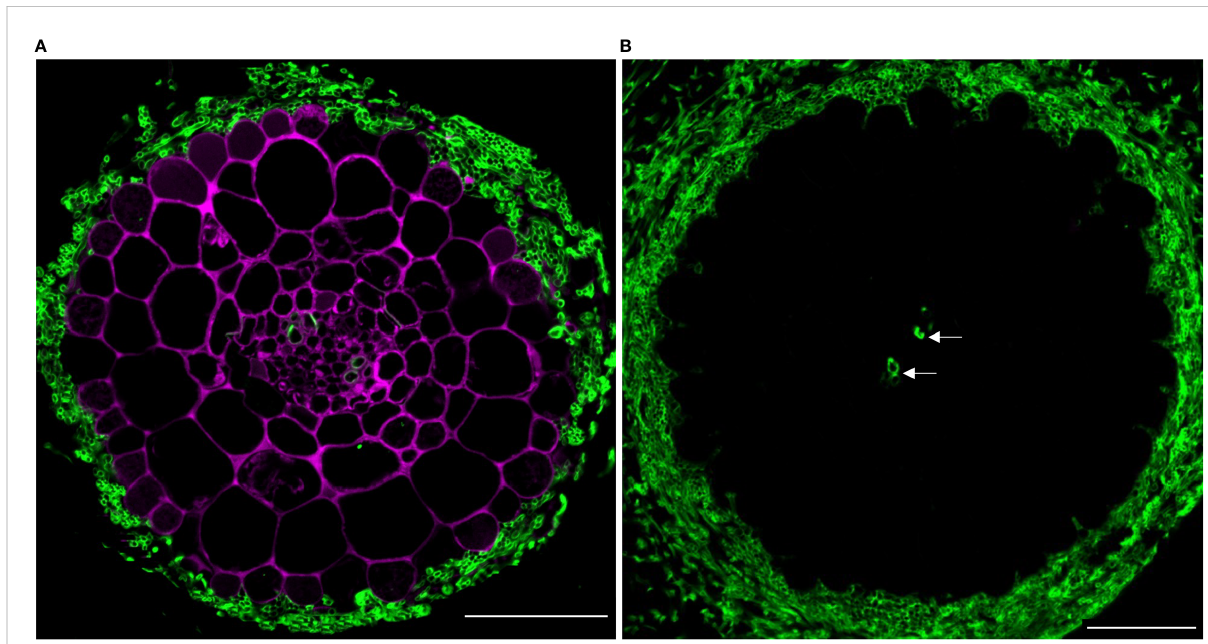
FIGURE 5 (A) In situ co-localization of PAs and chitin in the ectomycorrhizal fungus Laccaria bicolor in a lateral root cross-section (taken 500 µm from the root tip) of Populus tremula x Populus tremuloides . PAs in the root (DMACA staining; magenta) surrounded by a mantle of the symbiont (wheat germ agglutinin (WGA) staining; green) circa seven days into the colonization phase. (B) Similarly aged root stained with WGA only and without DMACA (negative control). To our observation, other than the fungal cell wall, WGA also binds to the xylem wall (indicated with arrow). Scale bar = 50 µm. The experiment was performed on 3-4 roots originating from separate plants yielding similar results in